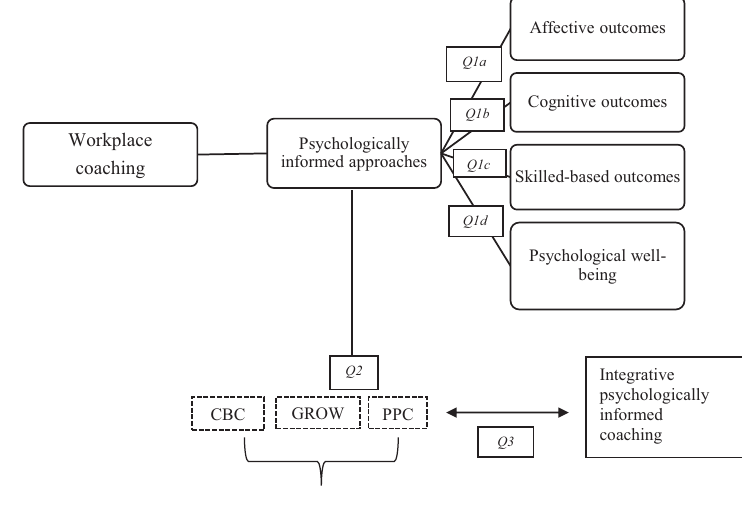
Figure 1. Conceptual framework of the present meta-